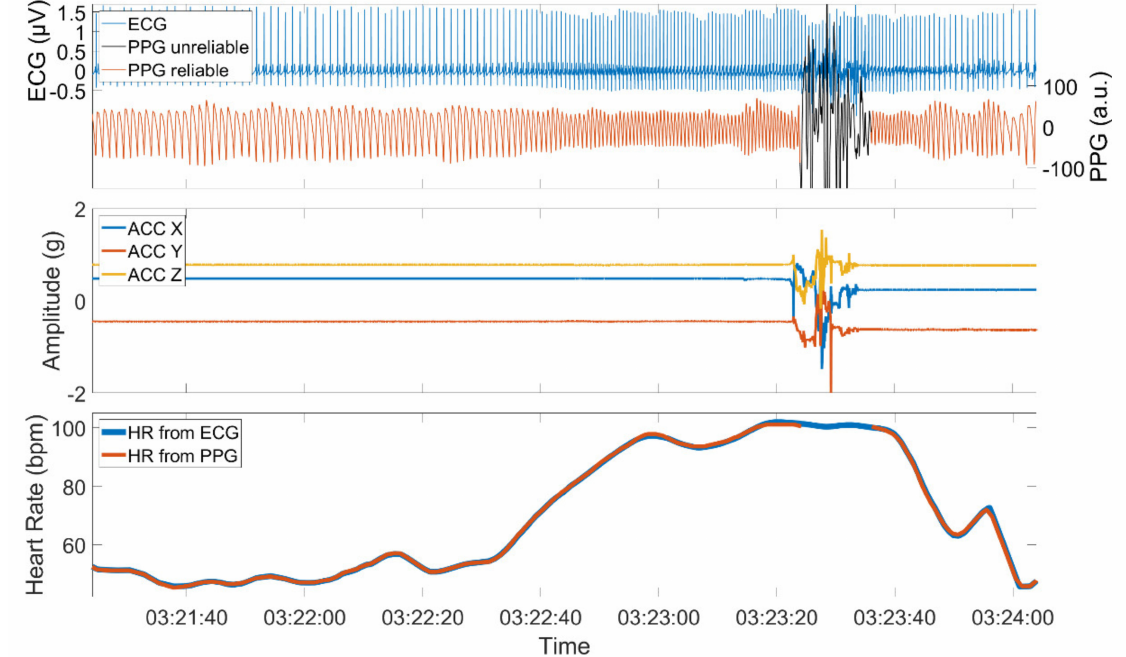
Figure 2. PPG and ECG signal (upper panel), the simultaneously recorded ACC signal (middle panel), and the derived PPG and ECG heart rate (lower panel). The PPG signal is composed of sections with high quality when the patient is at rest and sections of low quality when the patient is active. The PPG signal was automatically assessed using time-resolved spectral entropy to identify intervals containing